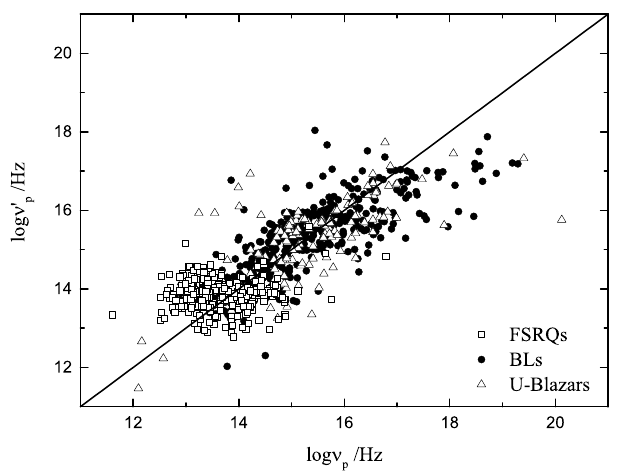
Figure 1. Correlations between estimated peak frequency using the empirical function and the fitted peak frequency for different classes of blazars. The solid line stands for the best-fit result. BL: BL Lacertae object; FSRQ: flat spectrum radio